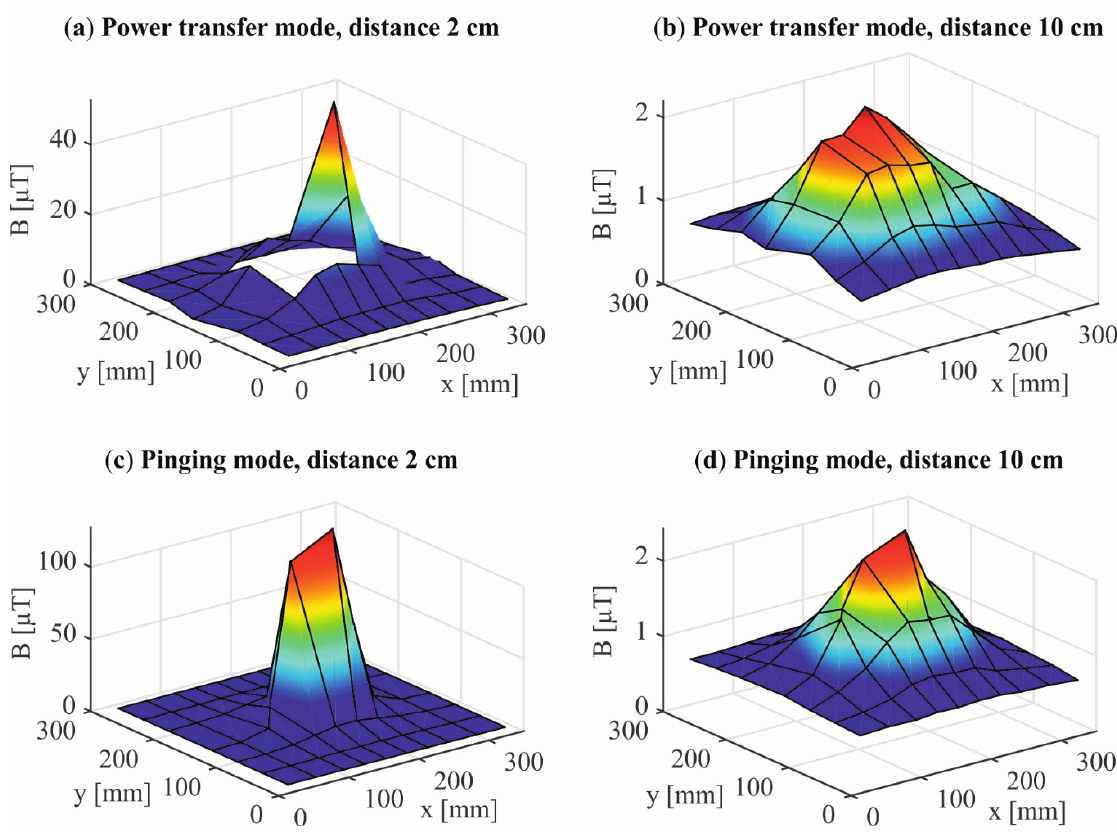
Figure 4. The measured magnetic flux density vs. the coordinates x and y on the plane is shown for the power transfer mode at two distances (2 cm ( a ) and 10 cm ( b )) and for the pinging mode at two distances (2 cm ( c ) and 10 cm ( d )). The missing values in the plot of the power transfer mode at 2 cm ( a ) are caused by the housing of the